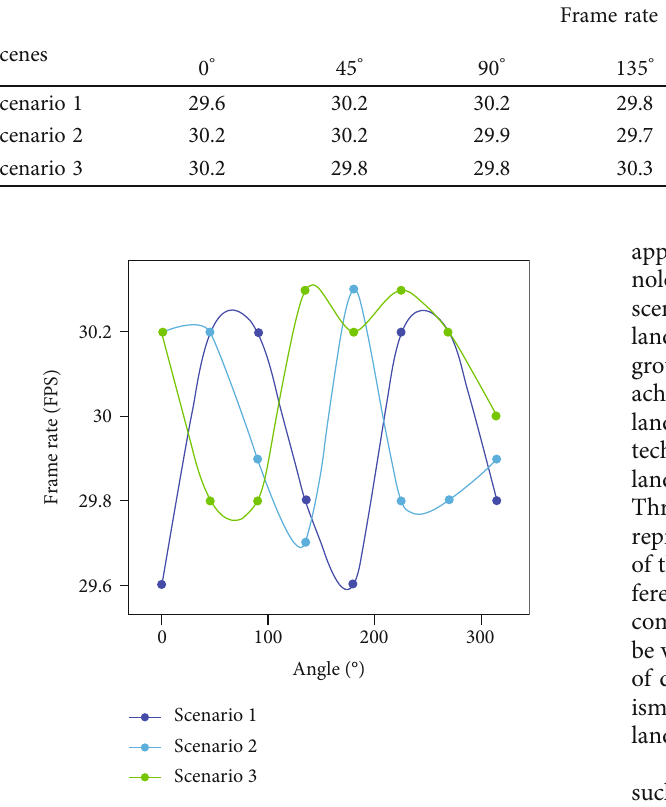
Figure 12: Frame rate trend graph.